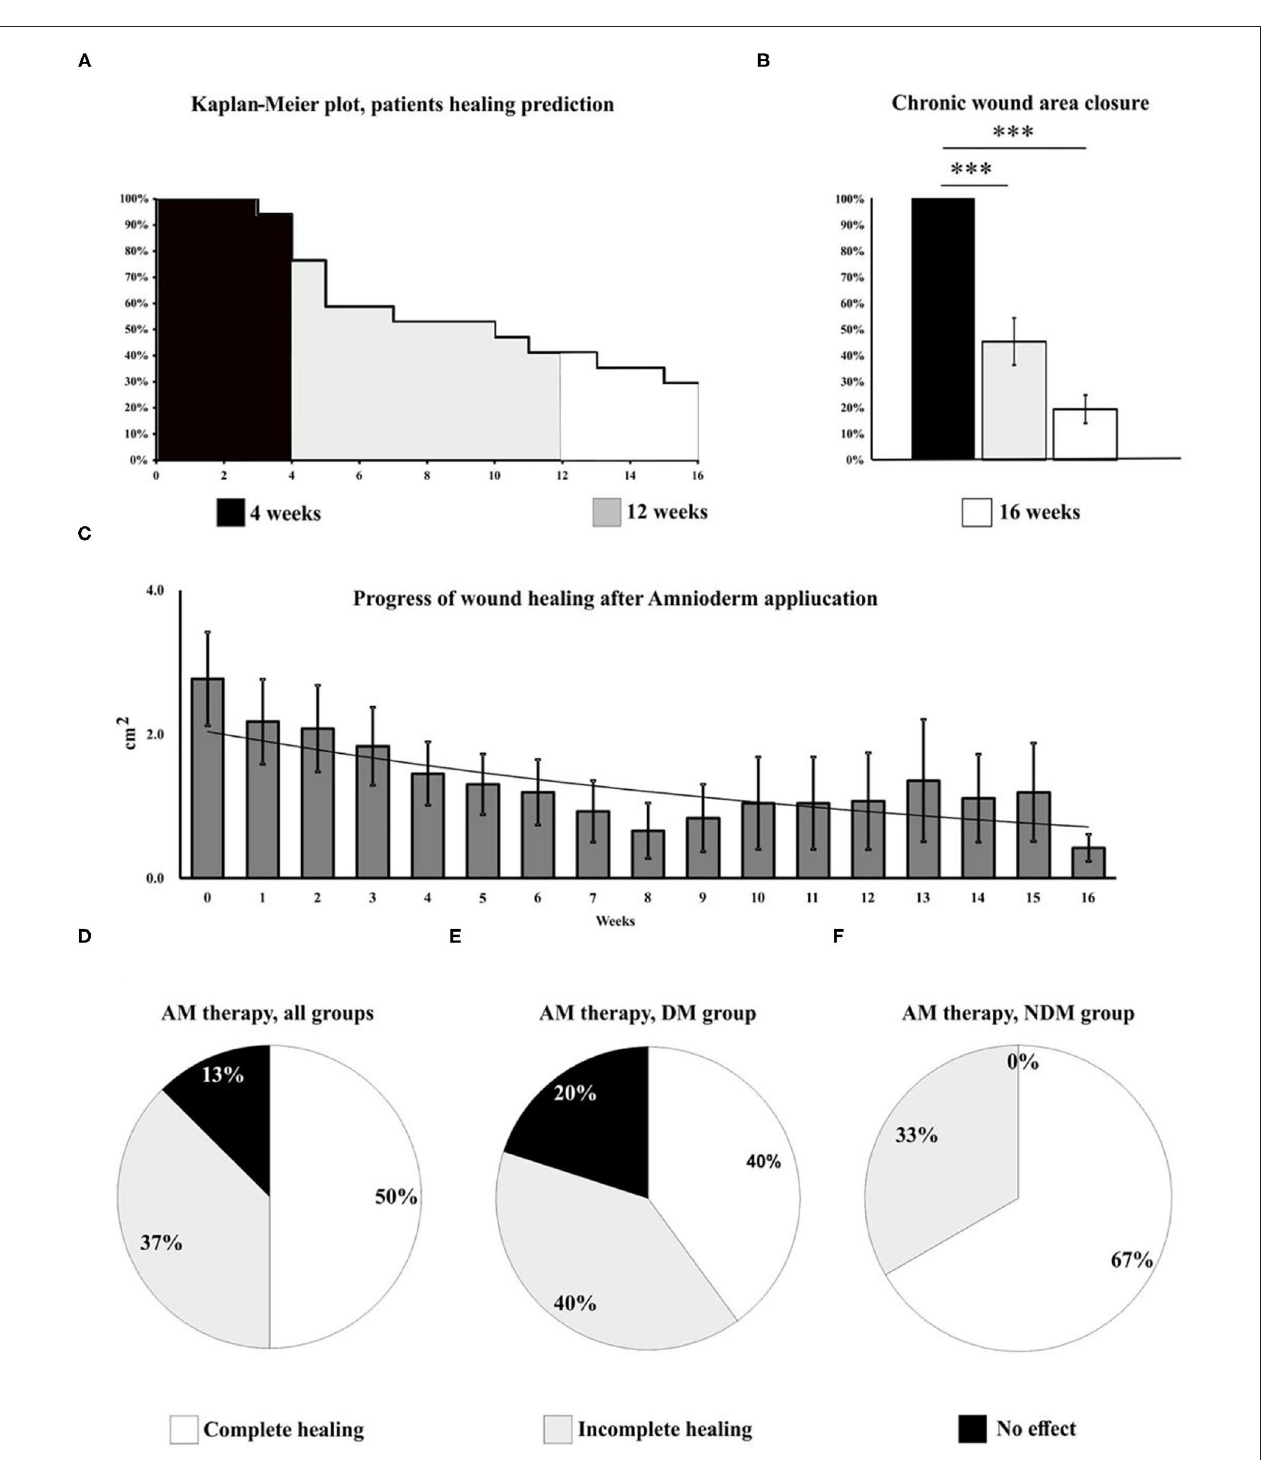
FIGURE 1 | Wound healing progress has been evaluated in all subjects included in the study for 16 weeks. The Kaplan–Meier plot shows the dynamics of patients exiting the study and predicts the healing potential of AM over time (A) . During the first 4 weeks of the study, wound granulation and epithelization were observed in 43.8% of the patients ( N = 7), three of which exited the study due to the complete wound healing. Between weeks 3 and 12 (A) , 80% wound size reduction (B) and total healing in 50% of all subjects ( N = 8) enrolled to the study (C , D) have been observed. The study shows complete ulcer healing in half of the patients, 37% of the wounds had a significant size reduction (up to 90% of baseline size), and 13% of the ulcers were not responding to the therapy ( N = 2). Therapy outcomes, DM group (E) : complete healing (40%, N = 4), significant reduction of the ulcer size (40%, N = 4), and unresponsive to the therapy (30%, N = 2). Therapy outcomes, NDM group (F) : complete healing (66%, N = 4), significant (up to 83%) reduction of the ulcer size (33%, N = 2), and unresponsive to the therapy (0%). A very significant changes ( p < 0.001) are marked as***.